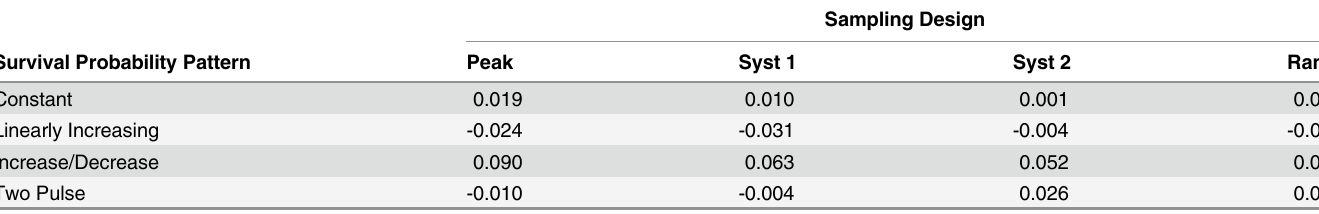
Table 1. Mean bias due to survival probability pattern and sampling design from 1000 simulations of n = 20 observations at each setting. Each entry is the mean difference between estimated survival probability and the true season-averaged survival probability used for the 1000 simulations at each setting. Bias results are comparable for the other sample sizes. For a sample size of n = 20, a typical standard error for the proportion estimate is on the order of 0.10; for a sample size of 100, it is on the order of